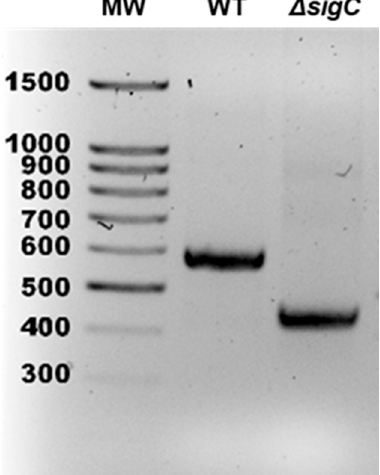
Figure 1. Confirmation of Mycobacterium tuberculosis Erdman Δ sigC . PCR analysis was used to confirm the 138-bp deletion within sigC of mutant ( Δ sigC ) relative to parent strain Erdman (WT). PCR bands of 587 and 449 bp are expected for WT and Δ sigC , respectively.